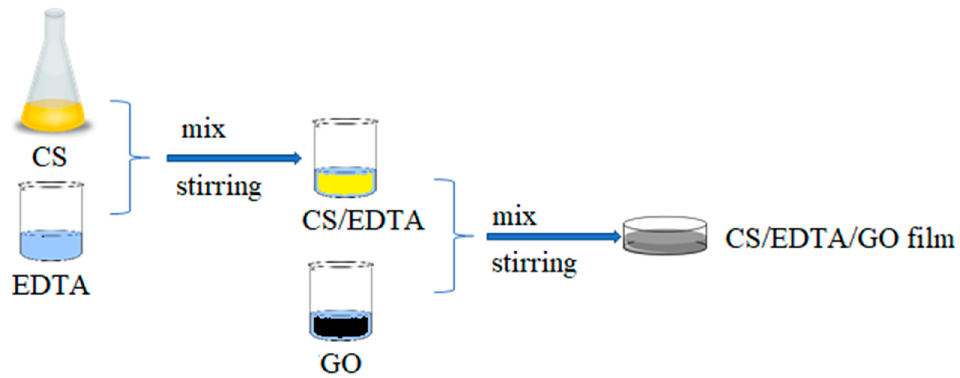
Scheme 2. Schematic illustration of the preparation of chitosan (CS)/ ethylenediaminetetraacetic acid